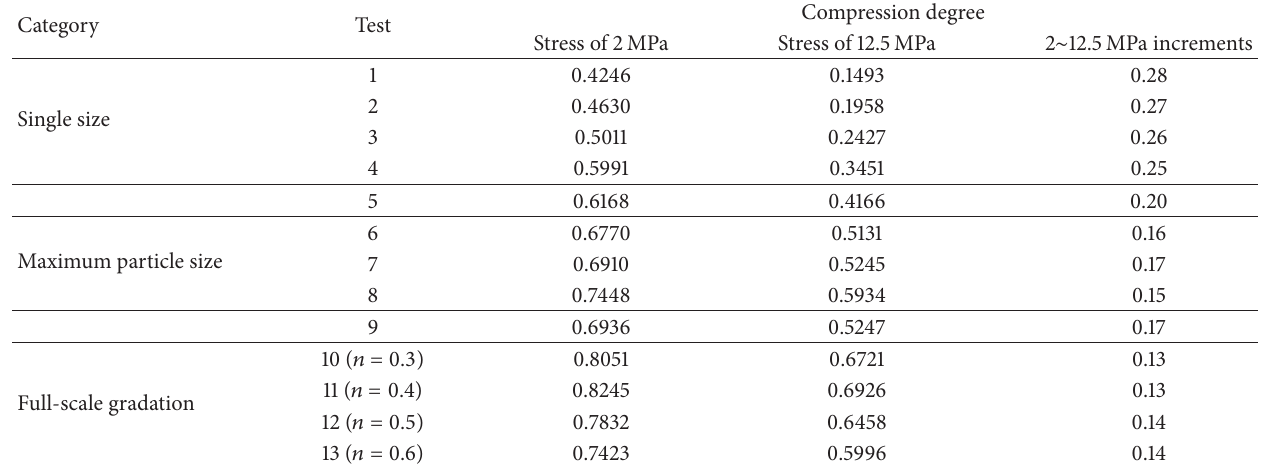
Table 3: Summary of compression degree-stress test results.